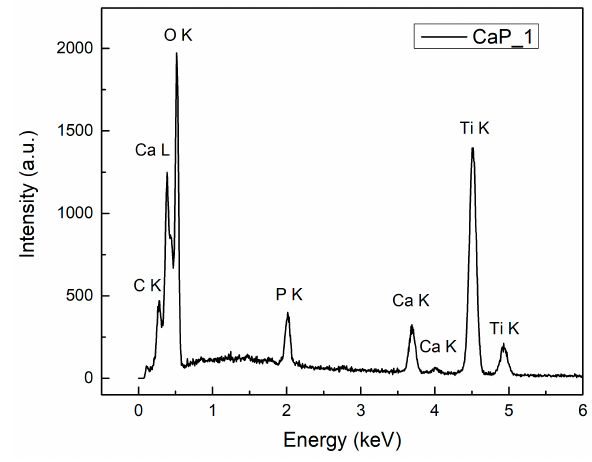
Figure 16. EDX spectrum of CaP_1.